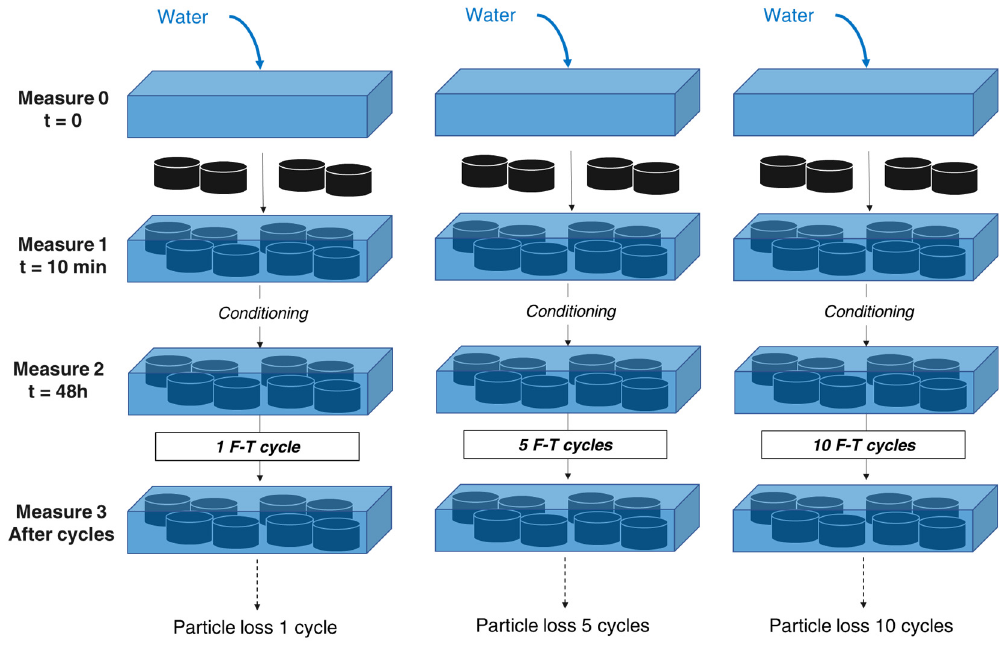
Figure 4. EC-TDS, pH, and particle loss measurement procedure.